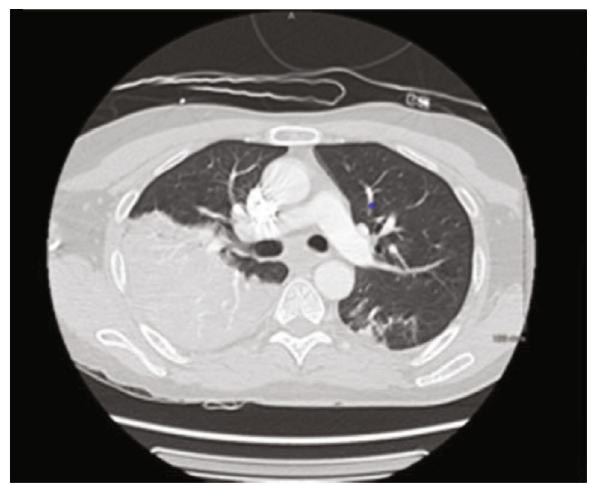
Figure 2: Chest X-ray: bilateral consolidations. Figure 1: CT scan: right lower lobe